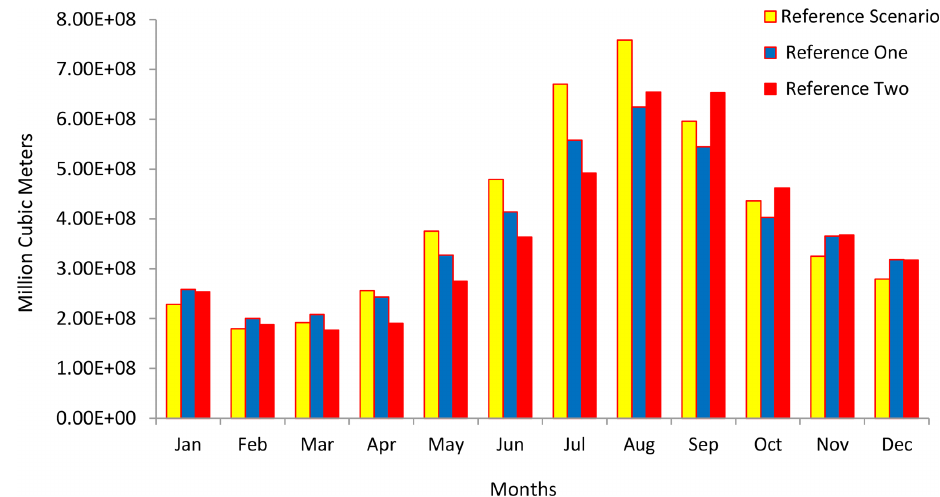
Figure 7. Simulated outflow (mcm) under current and future climate change for all